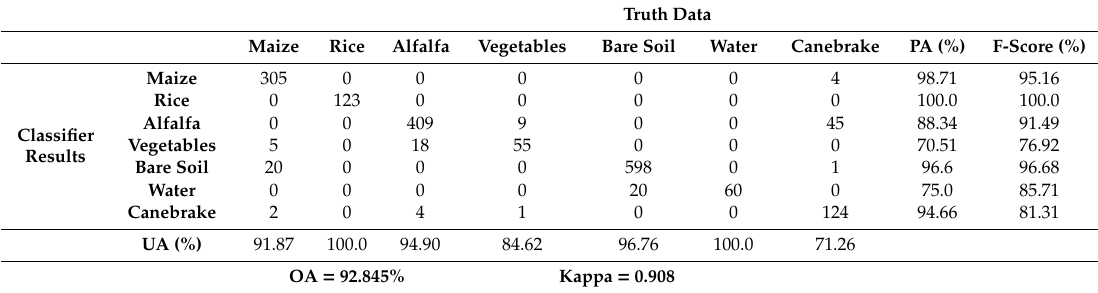
Table 8. Confusion matrix of the best output of the RF classifier among all feature sets (i.e., T-VSI feature set). The values which have been displayed for each class are the pixels number of validation samples.